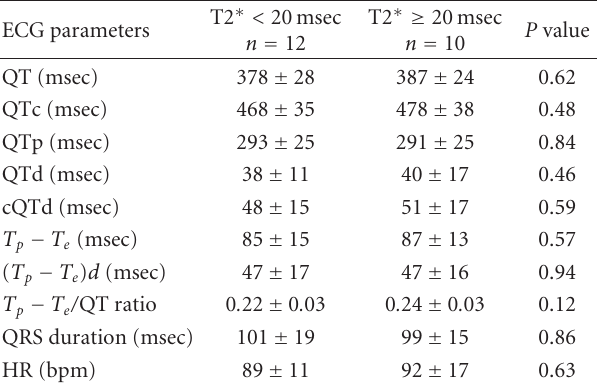
Table 3: Electrocardiographic findings of patients with β -TM according to cardiac T2 ∗ scores.